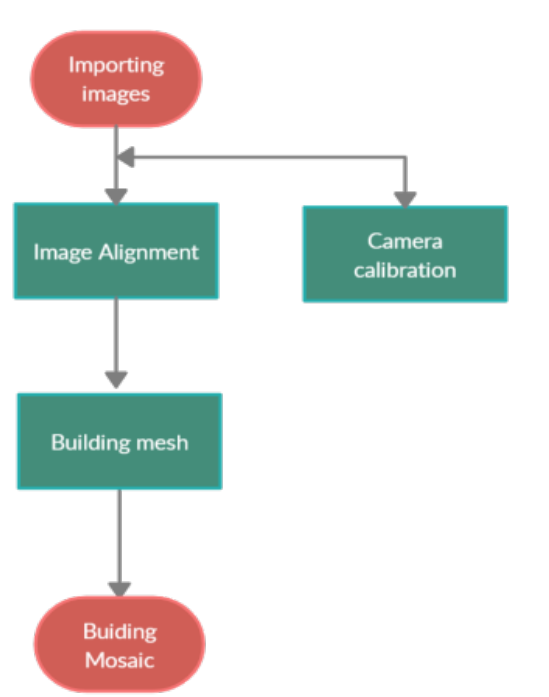
Figure 4 . Workflow for building mosaic in Agisoft™ using aerial images acquired at 13 and 15 m above the study area.